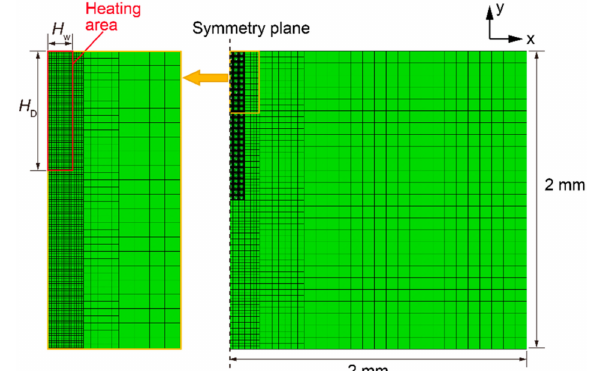
Figure 4. Finite-element model employed for